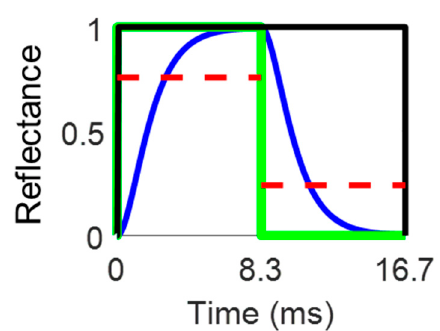
Figure 13. An illustration of the slow LC response time-impaired gray level accuracy.